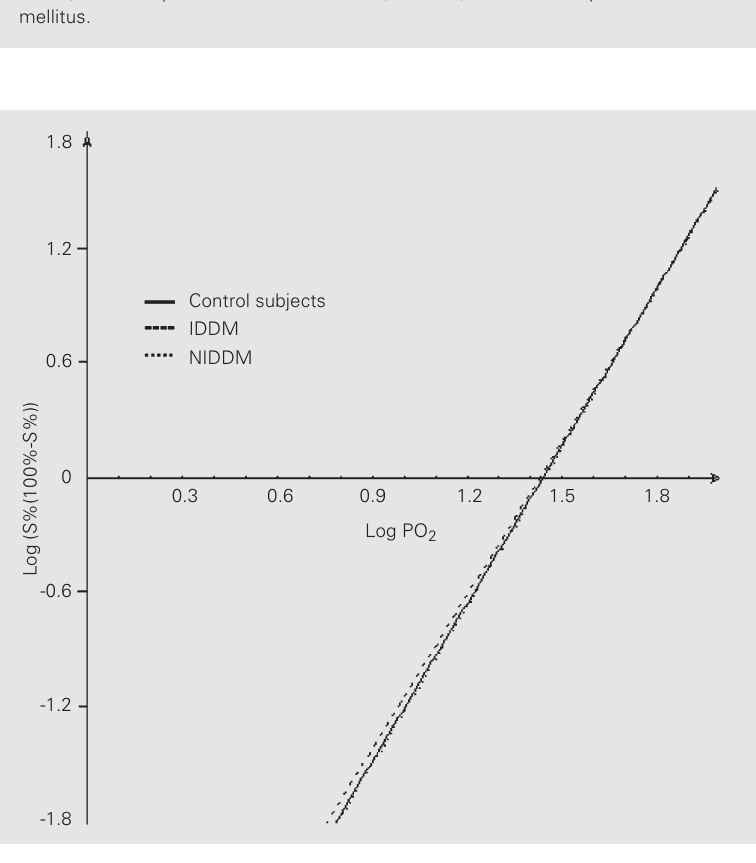
Data are reported as means ±